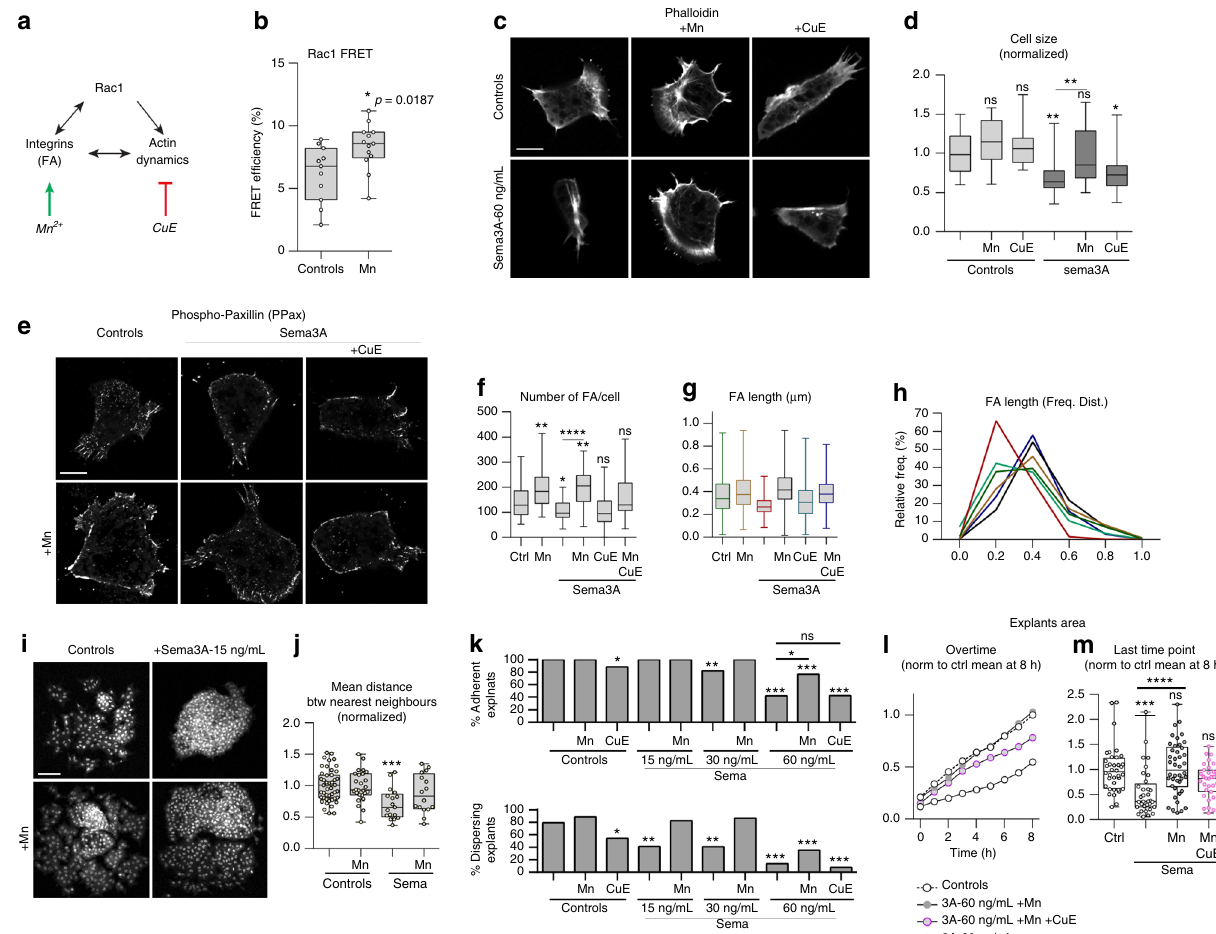
Fig. 7 Activation of adhesion and actin dynamics are required for rescue of exposure to Sema3A. a Effects of Manganese (Mn 2 + ) and CucurbitacinE (CuE) on adhesion and actin. b Rac1 activity (FRET) in control/treated cells with Mn 2 + (2 mM) for 2 h, n = 24 cells ( n controls = 11, n Mn2 + = 13) from two independent experiments, unpaired Student t -test, p value on the graph. c Cells cultured on Fibronectin with/without Mn 2 + (2 mM) or CuE (1 nM), Phalloidin. d Normalised cell area, n = 104 cells ( n controls = 15, n Mn2 + = 17, n CuE = 14, n Sema = 20, n Sema + Mn2 + = 20, n Sema + CuE = 18), ANOVA, multiple comparisons; ** p (ctl vs sema) = 0.0036; ** p (sema vs sema + Mn) = 0.0053; and * p (ctl vs sema + CuE) = 0.0210. e PPax immunostaining, cells cultured on Fibronectin with/without Sema3A at 60 ng/mL with/without Mn 2 + (2 mM) and/or CuE (1 nM). f Focal adhesion per cell per condition depicted in e , n = 178 cells ( n controls = 29, n Mn2 + = 29, n Sema = 30, n Sema + Mn2 + = 30, n Sema + CuE = 30, and n Sema + Mn2 ++ CuE = 30) from two independent experiments; ANOVA, multiple comparisons; * p (ctl vs sema) = 0.0348; ** p (ctl vs Mn) = 0.0053; ** p (ctl vs sema + Mn) = 0.0026; **** p (sema vs sema + Mn) < 0.0001. g , h FA length and frequency distribution from e , n of individual FA analysed: n controls = 2197, n Mn2 + = 1688, n Sema = 3101, n Sema + Mn2 + = 2708, n Sema + CuE = 2469, n Sema + Mn2 + + CuE = 2328, from two independent experiments. Colour code same as in g . i Explants cultured on Fibronectin or Fibronectin plus Sema3A at 15 ng/mL with/without Mn 2 + (2 mM), stained with DAPI. j Mean distance between nearest neighbours from i , n = 106 explants ( n controls = 47, n Mn2 + = 26, n Sema = 17, and n Sema + Mn2 + = 16), from two independent experiments; ANOVA, multiple comparisons, *** p = 0.0005. k Percentage of adherent and dispersing explants after a 3-hour culture on Fibronectin or Fibronectin plus Sema3A at 15, 30 or 60 ng/mL with/without Mn 2 + (2 mM) and/or CuE (1 nM), n = 268 explants ( n controls = 52, n Mn2 + = 26, n CuE = 26, n Sema15 = 17, n Sema15 + Mn2 + = 17, n Sema30 = 22, n Sema30 + Mn2 + = 22, n Sema60 = 43, n Sema60 + Mn2 + = 17, and n Sema60 + Mn2 ++ CuE = 26) from fi ve independent experiments. Comparisons of proportions were made using contingency tables 60 . Null hypothesis rejected if T > 3.841 (* α = 5%); T > 6.635 (** α = 1%); T > 10.83 (*** α = 0.1%). l Normalised area overtime for explants cultured on Fibronectin or Fibronectin plus Sema3A at 60 ng/mL with/without Mn 2 + (2 mM), n = 145 explants ( n controls = 38, n Sema = 33, n Sema + Mn = 42, and n Sema + Mn + CuE = 32) from four independent experiments. m Normalised explant areas after 8 h for conditions shown in l ; ANOVA, multiple comparisons, *** p = 0.0005; **** p < 0.0001. Scale bars ( c , e ), 10 μ . Scale bar in i , 100 μ . Box and whiskers plot: the box extends from the 25th to the 75th percentile; the whiskers show the extent of the whole dataset. The median is plotted as a line inside the box. Source data are provided as a Source Data fi